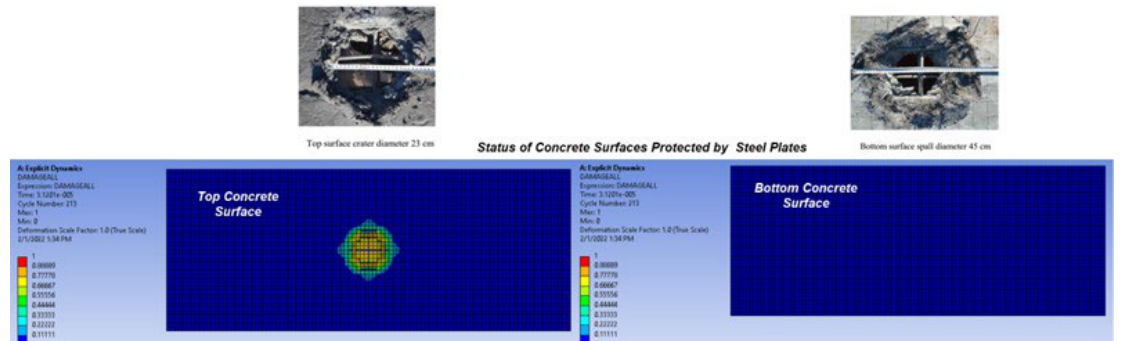
Figure 18- Status of top & bottom concrete surfaces of UHPC-4 slab protected by 1 mm steel plates at both